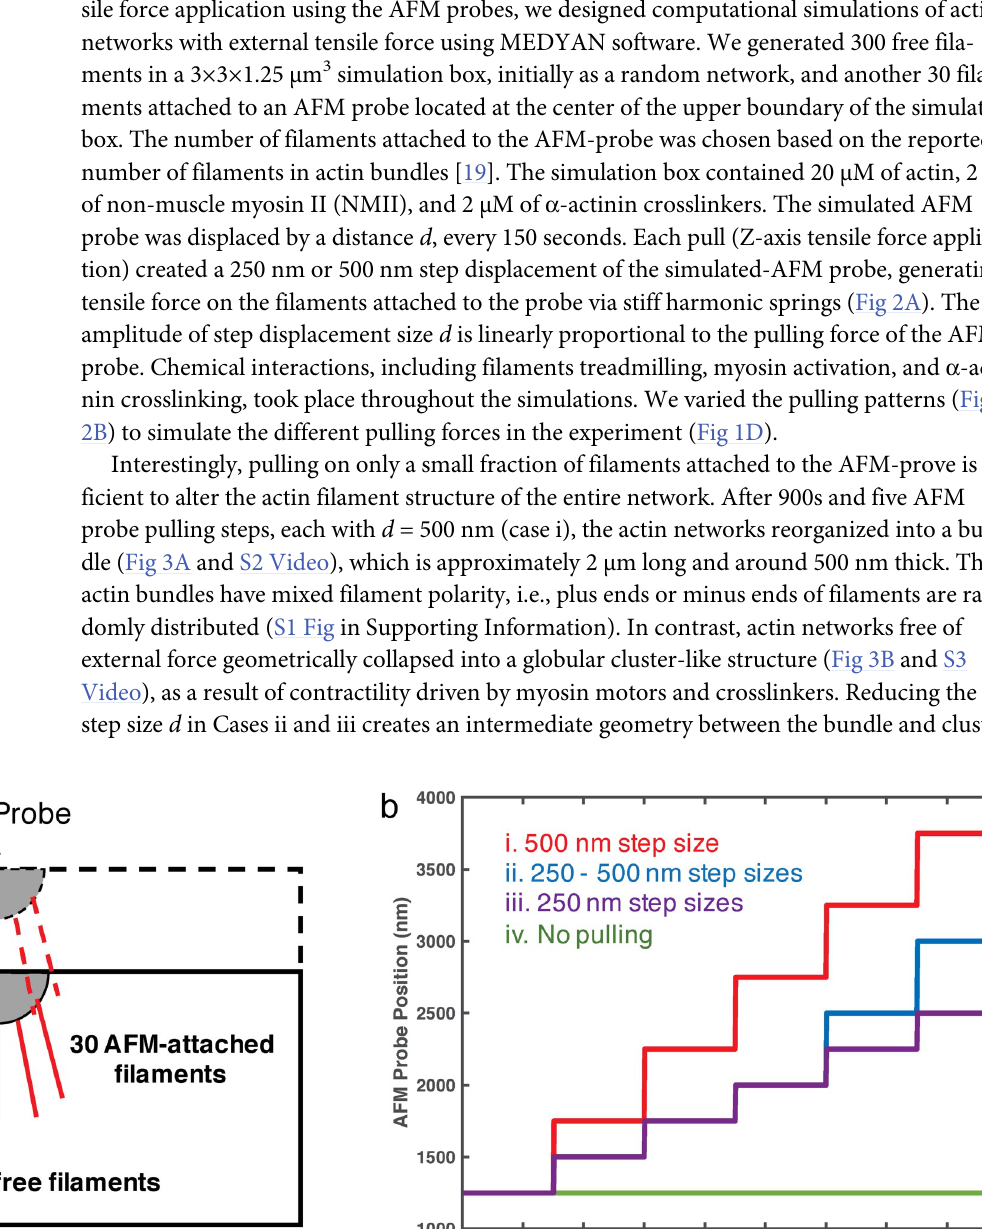
PLOS Computational Biology | https://doi.org/10.1371/journal.pcbi.1007693 June 10,